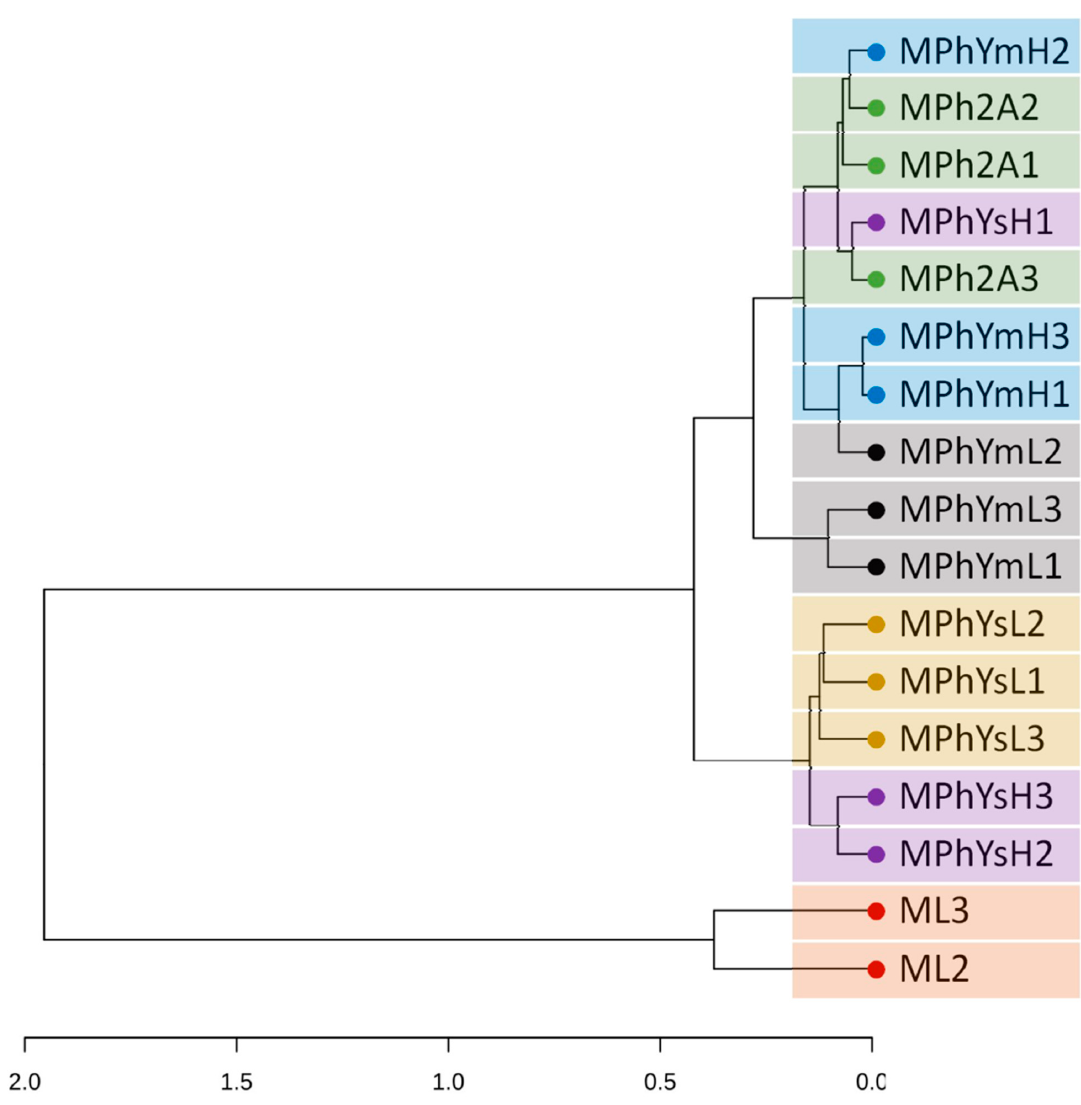
Figure 2. Based on MiSeq sequencing data, cluster analysis of the bacteria community based on all OTUs detected for culture-independent/dependent samples (clustering method = UPGMA, distance = Euclidean). ML, culture-independent mother leaf; MPhYmH, culture-dependent on ho- mologous maize broth 25 mL L − 1 ; MPhYmL, culture-dependent on homologous maize broth 5 mL L − 1 ; MPhYsH culture-dependent on heterologous sunflower broth 25 mL L − 1 ; MPhYsL, culture-dependent on heterologous sunflower broth 5 mL L − 1 ; MPh2A, culture-dependent of R2A culture medium.